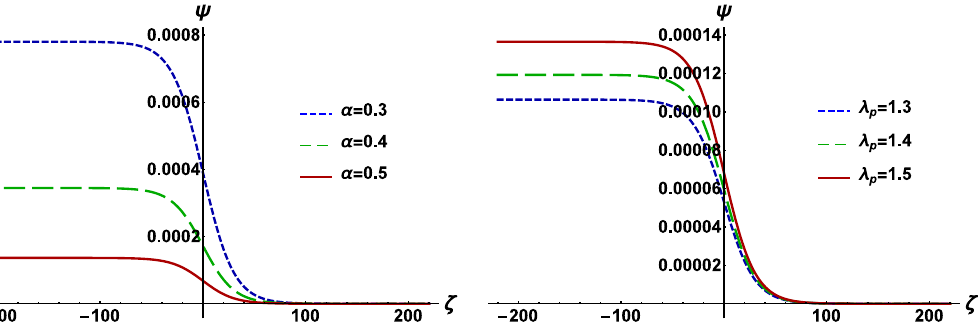
Figure 3. The variation of Ψ with ζ for different values of α ( left panel ) and λ p ( right panel ) under consideration of α 4 > α 4 c along with α 1 = 1.5, α 2 = 0.05, α 3 = 0.03, α 4 = 1.5, λ e = 1.7, λ d = 0.05, δ = 30 ◦ , η = 0.3, U 0 = 0.01, and V p ≡ V p +